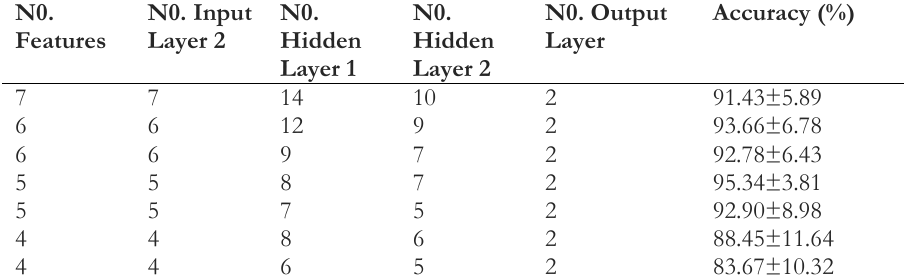
Table 4. Structure of optimal network for some different features.